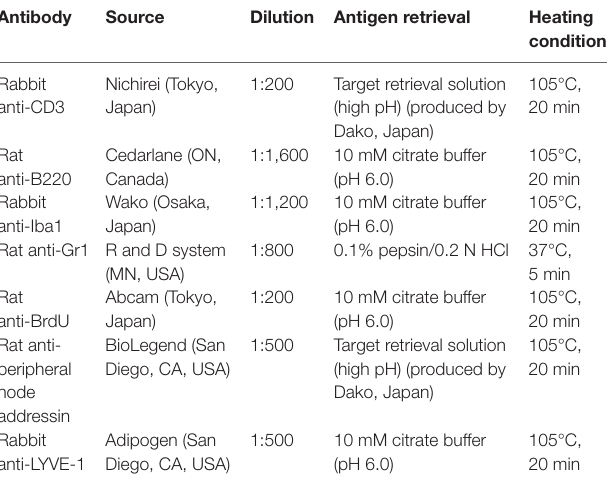
TaBle 1 | List of antibodies, working dilutions, and methods for antigen retrieval. antibody